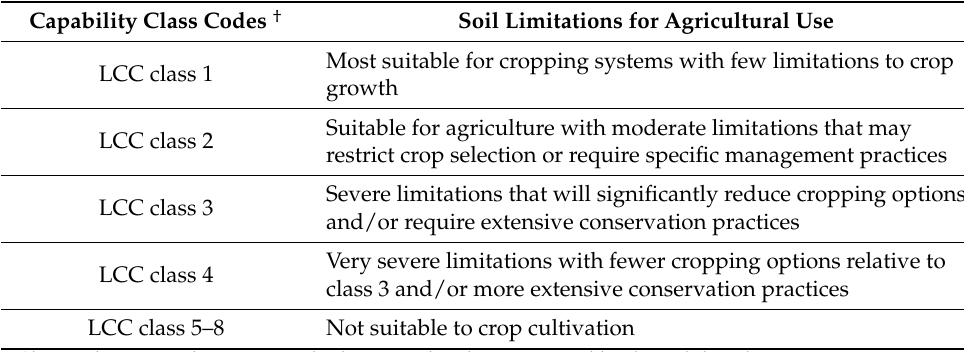
Table 1. Abbreviated Land Capability Classification Ranking System (USDA).